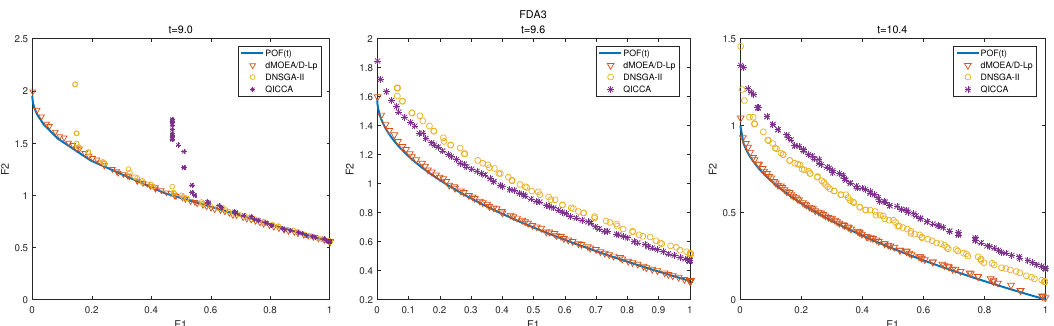
Figure 5. Solution sets obtained by three algorithms at different times on FDA2 in case of τ T = 15, n T = 5.